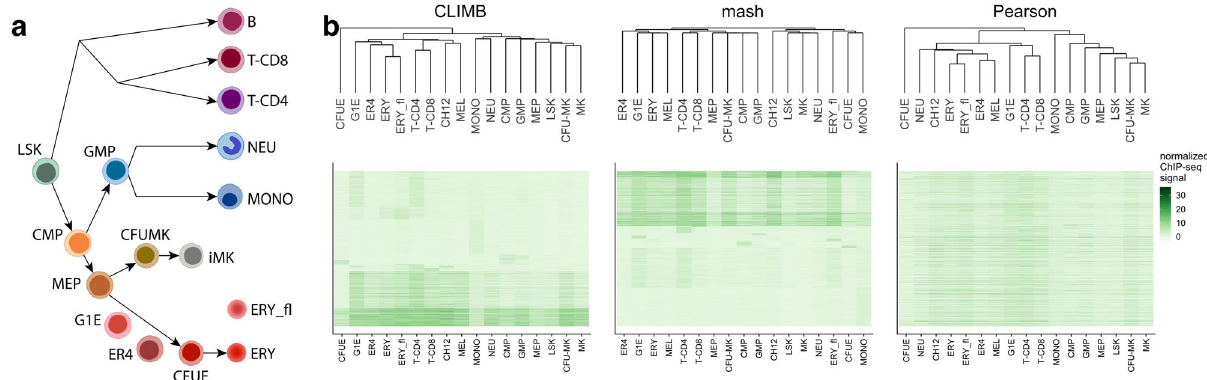
Fig. 2 | CLIMB uncovers interrelationships among hematopoietic cell popula- tions based on CTCF binding patterns. a Expected relationship among cell populations. b Heatmaps displaying bi-clusterings of all ChIP-seq data for chro- mosome 11 based on CLIMB, mash, and Pearson correlation. The columns, corre- sponding to different cell populations, are ordered according to the dendrogram